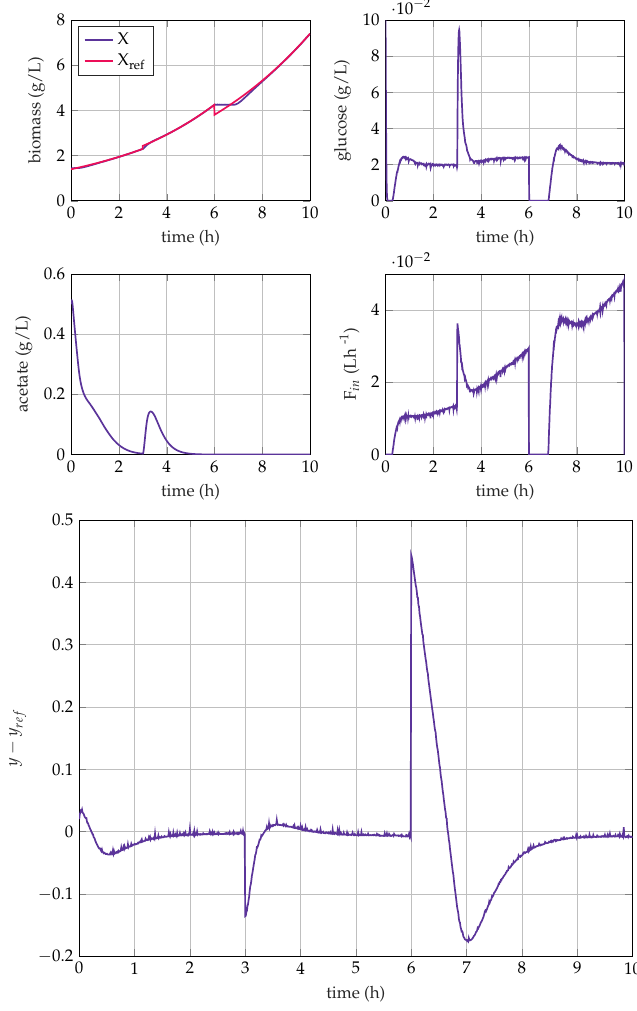
Figure 10. Closed-loop response to a setpoint change µ set = 0.18 h − 1 and µ set = 0.22 h − 1 . The PID parameters are chosen to have an overall dynamic behavior close to the one obtained by the GMC, the parameters values are K p = 0.07, K i = 0.01, K d = 0.01, and T f = 0.5. The first-order controller gain G 1 is chosen equal to the GMC proportional